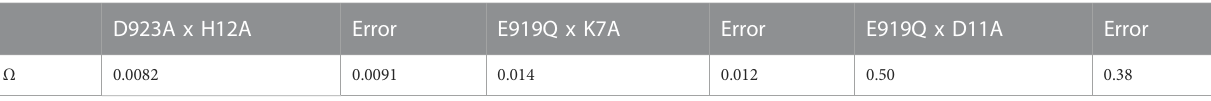
TABLE 4 Coupling coef fi cients from double-mutant cycle